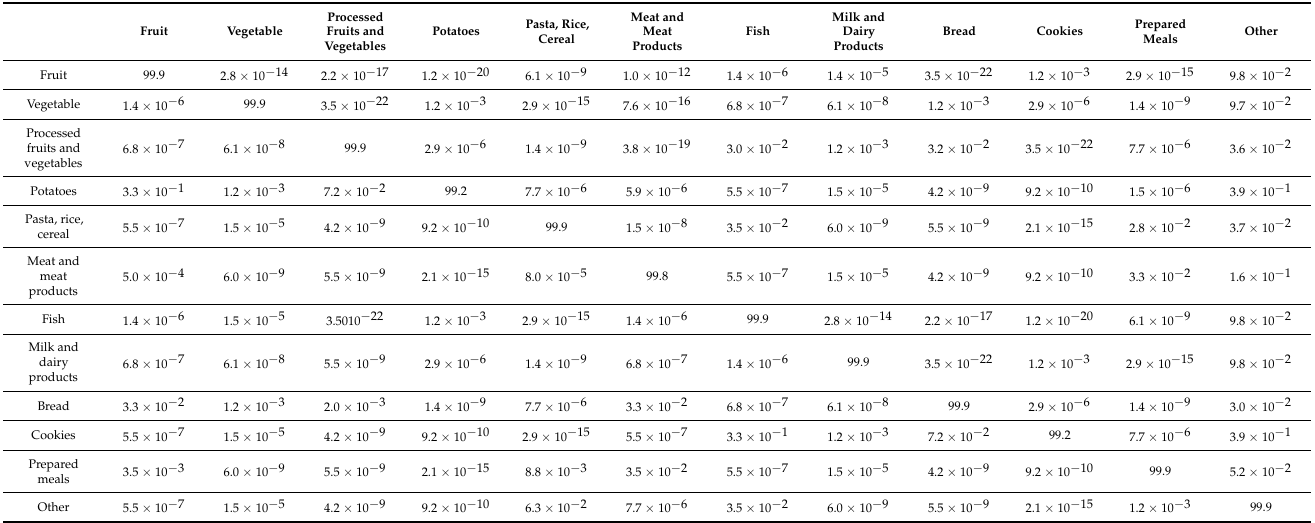
Table 2. Confusion matrices for proposed CNN model with average composite food category percentage